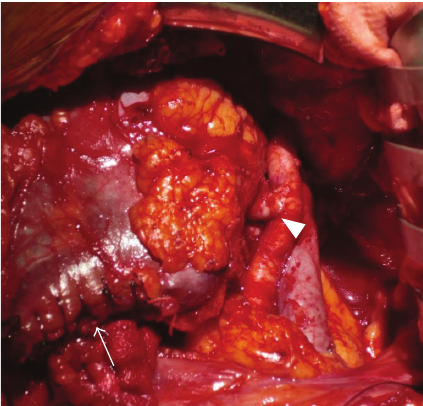
Figure 4: The horseshoe kidney after transplantation into the recipient. The edge of the isthmus was sutured (arrows). The renal artery was anastomosed to the external iliac artery (arrowhead), and the renal vein was anastomosed to the external iliac vein.